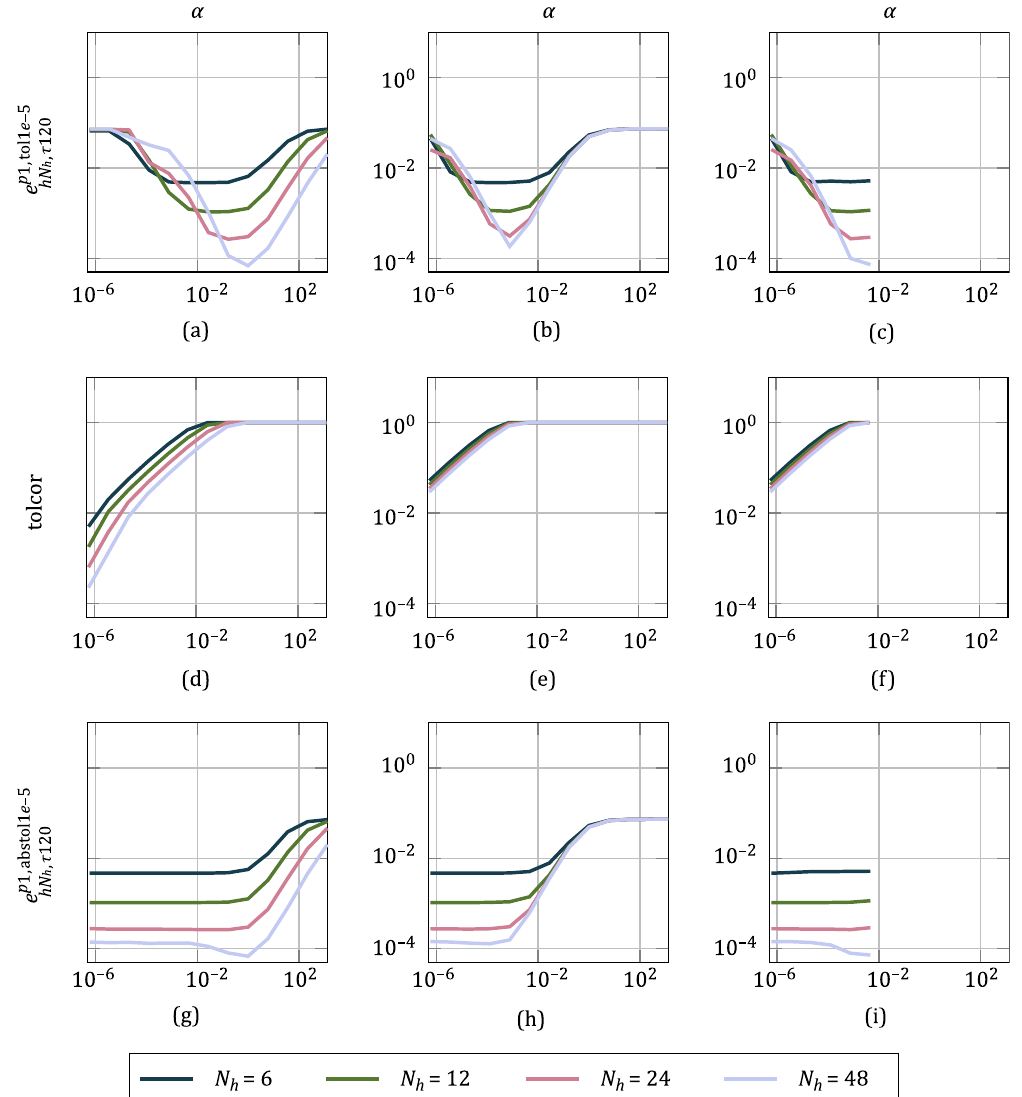
Figure 6. Penalty schemes and absolute tolerances, cf. the section Parameter studies for the penalty schemes . The error e p 2 ; tol 1 e (cid:3) 5 for a fi xed relative residual tol ¼ 10 (cid:3) 5 (top row), the correction of the residual tolcor (middle row), and for a fi xed absolute residual abstol ¼ 10 (cid:3) 5 (bottom row) for varying space discretizations N h versus the penalization parameter α for the schemes pena (left), pero (middle), and nits (left) for Test Case